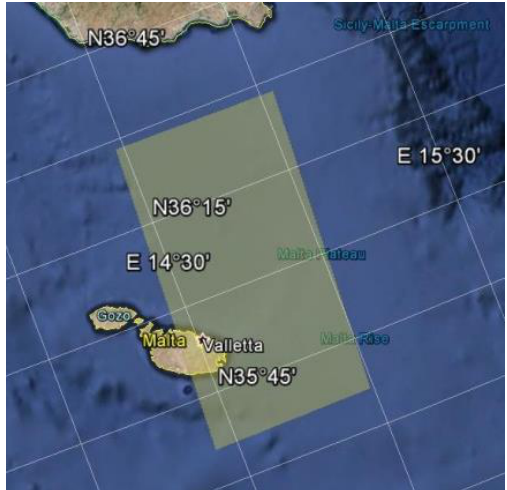
Figure 1. The experiment’s test site (acquired from Google Earth).